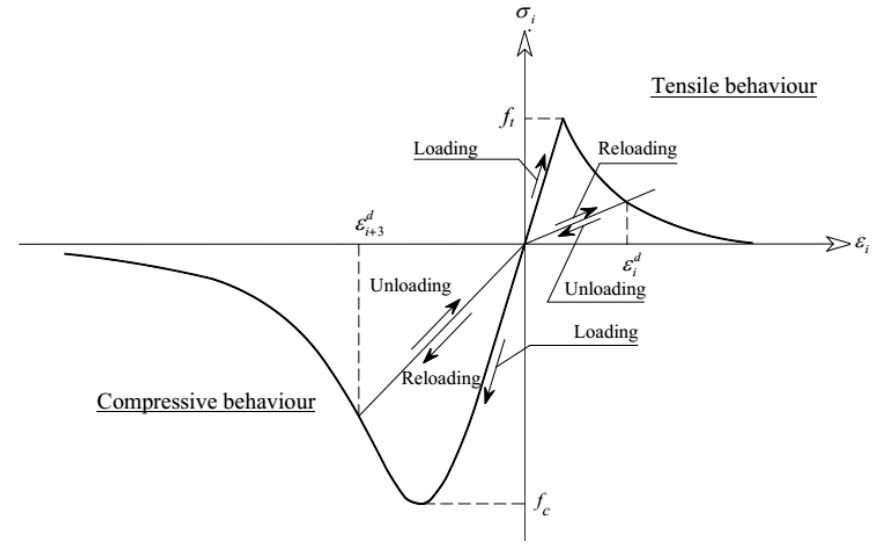
Figure 9. Nonlinear behavior of the masonry materials in the numerical model: Total Strain Rotating Crack model